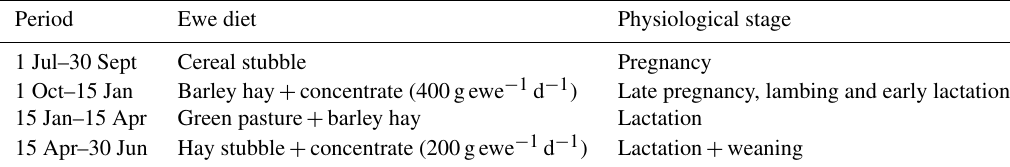
Table 1. Ewe diet during pregnancy and lactation.